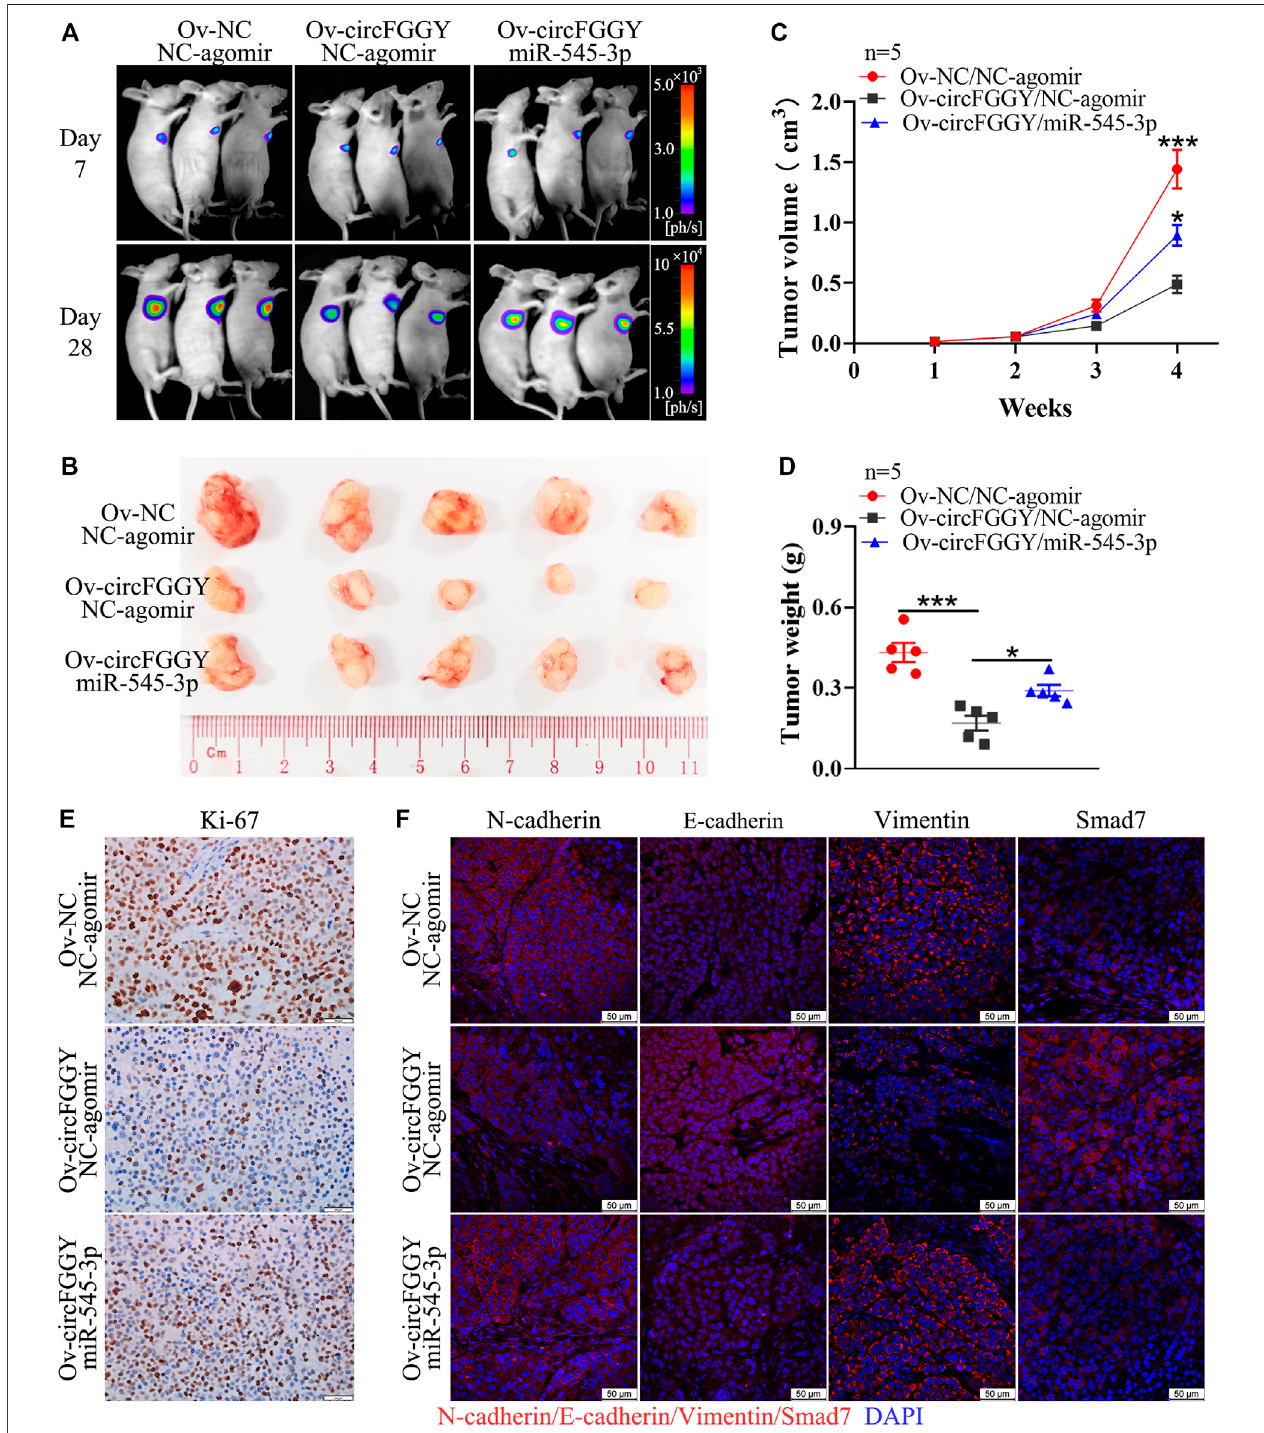
FIGURE7| CircFGGYinhibitsthegrowthofHCCthroughthemiR-545-3p/Smad7axis invivo . (A) .Representativebioluminescenceimagesofxenografttumorsin mice at day 7 and day 28 after injection of MHCC97H cells. (B) . Representative images of the MHCC97H xenograft tumors after 4 weeks of tumor growth in circFGGY overexpression, circFGGY/miR-545-3p overexpression and NC group. (C,D) The volume and weight of subcutaneous xenograft tumors. (E) IHC analysis of Ki-67 expression in circFGGY overexpression, circFGGY/miR-545-3p overexpression and NC group. Scale bar, 50 µm. (F) Immuno fl uorescence (IF) analysis of EMT biomarkers and Smad7 expression in xenograft tumor tissues from the circFGGY overexpression, circFGGY/miR-545-3p overexpression and NC groups. Scale bar, 50 µm. NC group: mice were subcutaneous injected with NC-overexpressing MHCC97H cells and NC-agomir was injected around the xenograft tumor every 4